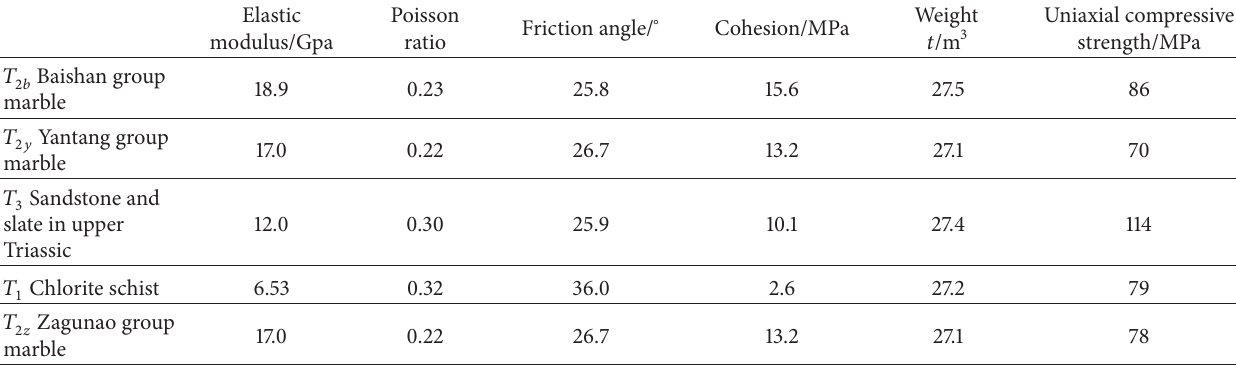
Table 1: Strata physical and mechanical properties for the Jinping